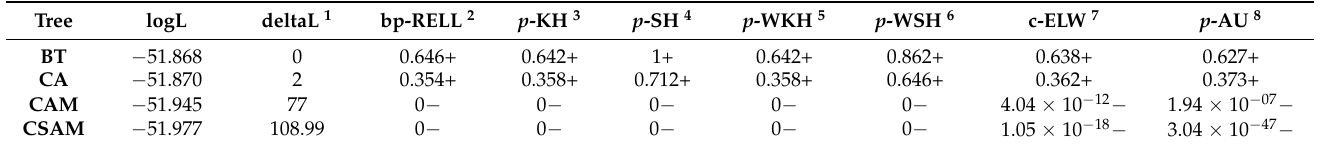
Table 1. Results of topology test. Scores of constrained trees: (BT) = Best unconstrained tree, (CA) = Craspedostauros and Achnanthes , (CAM) = Craspedostauros , Achnanthes , and Mastogloia and (CSAM) = Craspedostauros , Staurotropis , Achnanthes and Mastogloia . Plus signs denote the 95% confi- dence sets. Minus signs denote significant exclusion. All tests performed 10,000 resamplings using the RELL